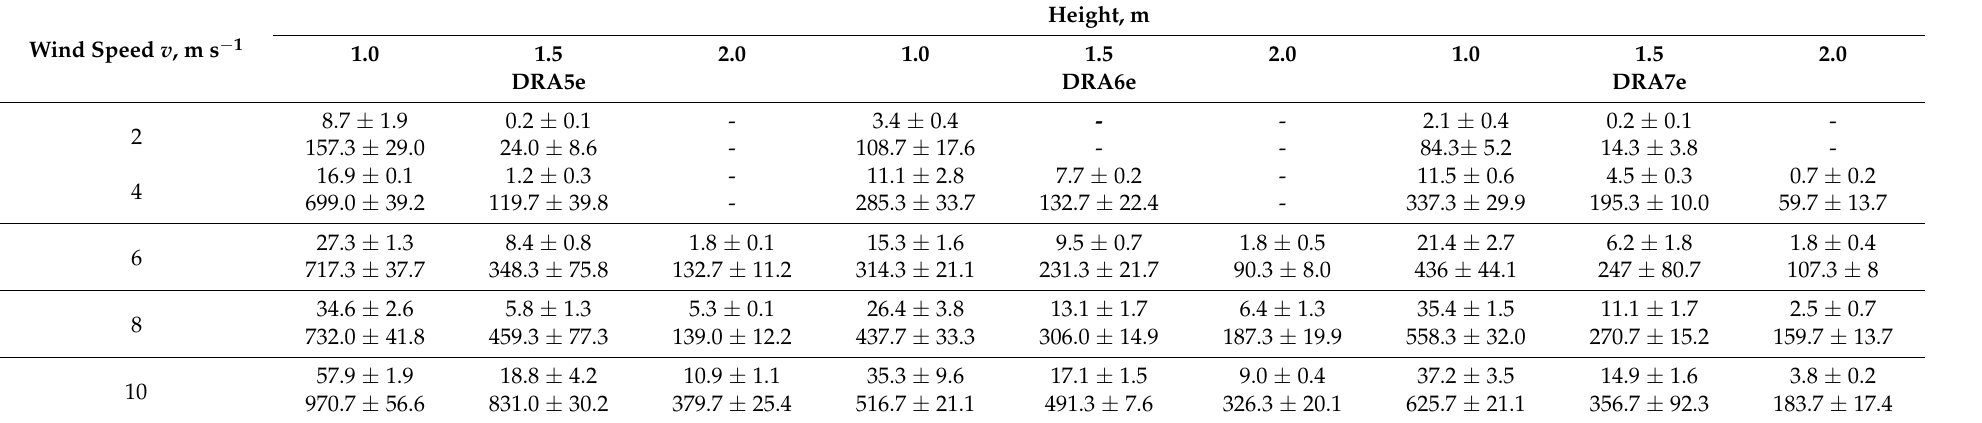
Table 7. Water-sensitive paper coverage (upper line, %) and the number of droplets (lower line) at 5 m from the target zone of the sprayer (1.0–2.0 m height measured vertically in direction of the y-axis from ground, Figure 3) when sprayed with five standard flat spray nozzles using a